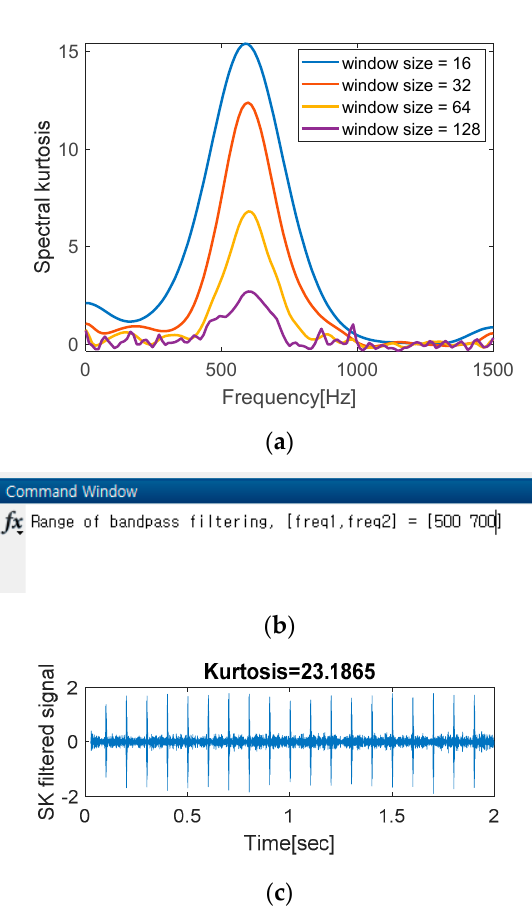
Figure 10. Demodulation band selection: ( a ) spectral kurtosis for different window lengths, ( b ) Figure10. Demodulationbandselection: ( a )spectralkurtosisfordi ff erentwindowlengths, ( b )frequency frequency band selection input in MATLAB, and ( c ) vibration signal after band-pass filtering. band selection input in MATLAB, and ( c ) vibration signal after band-pass